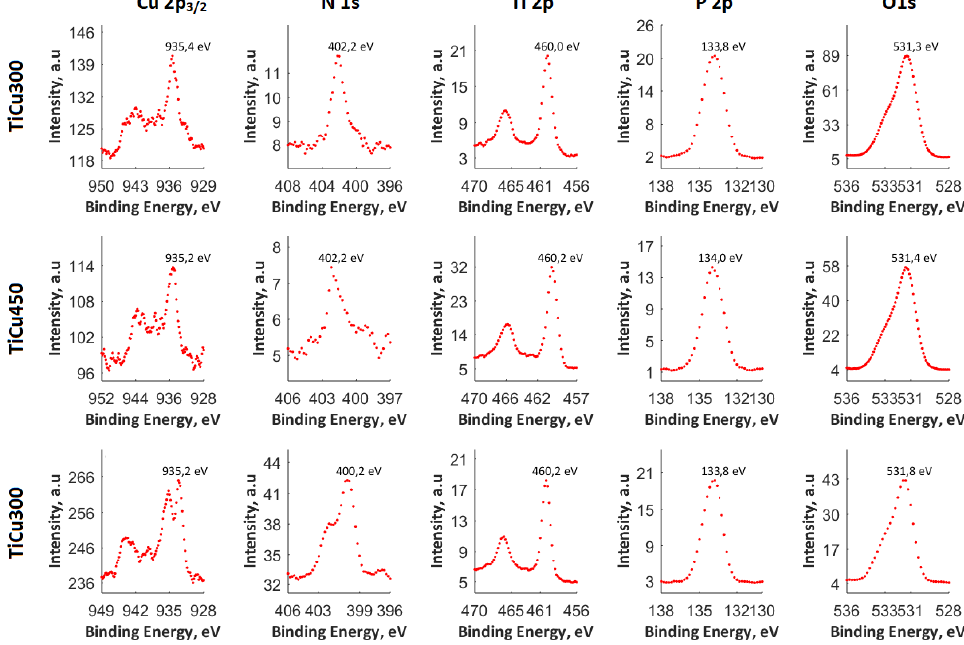
Figure 4. The XPS spectra of the three coatings: TiCu300, TiCu450, and TiCu600.